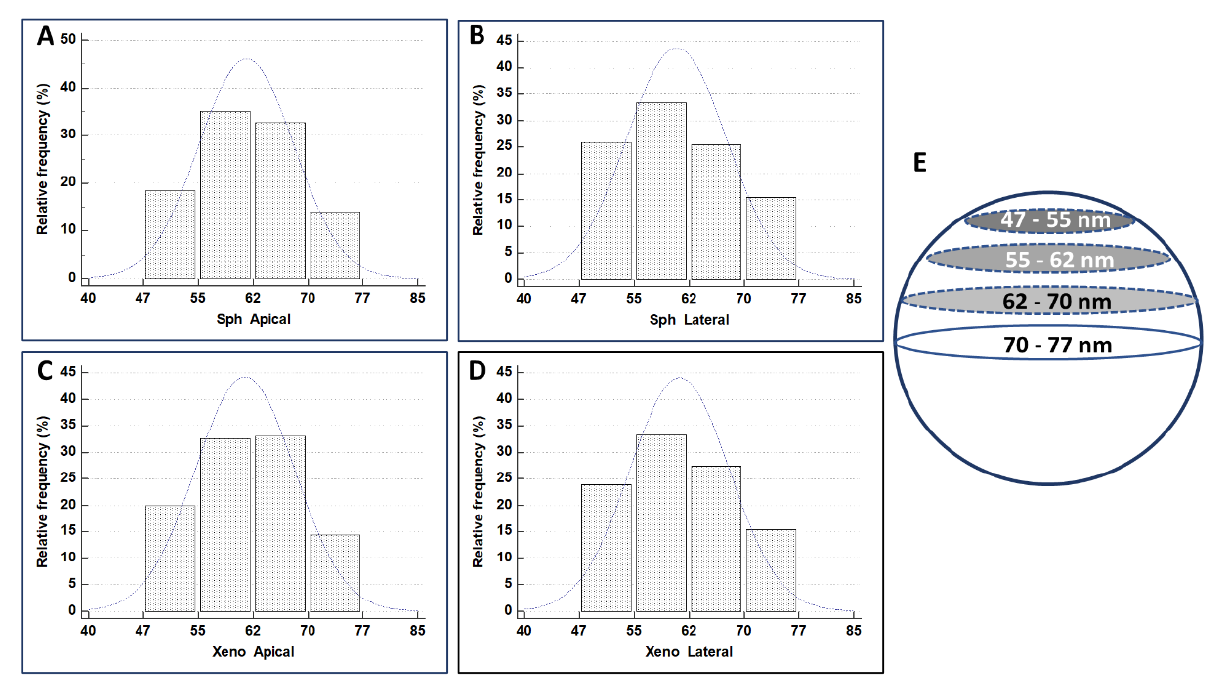
Figure 11. Histograms illustrate the distribution of diameter values in apical-secreted and basolateral-secreted exosomes in MTSs and xenografts. ( A ) Exosome diameter in spheroid apical secretion. ( B ) Exosome diameter in spheroid basolateral secretion. ( C ) Exosome diameter in xenograft apical secretion. ( D ) Exosome diameter in xenograft basolateral secretion. ( E ) The maximum diameter is the less frequent, and the others occur at least two times (over and above the equator).